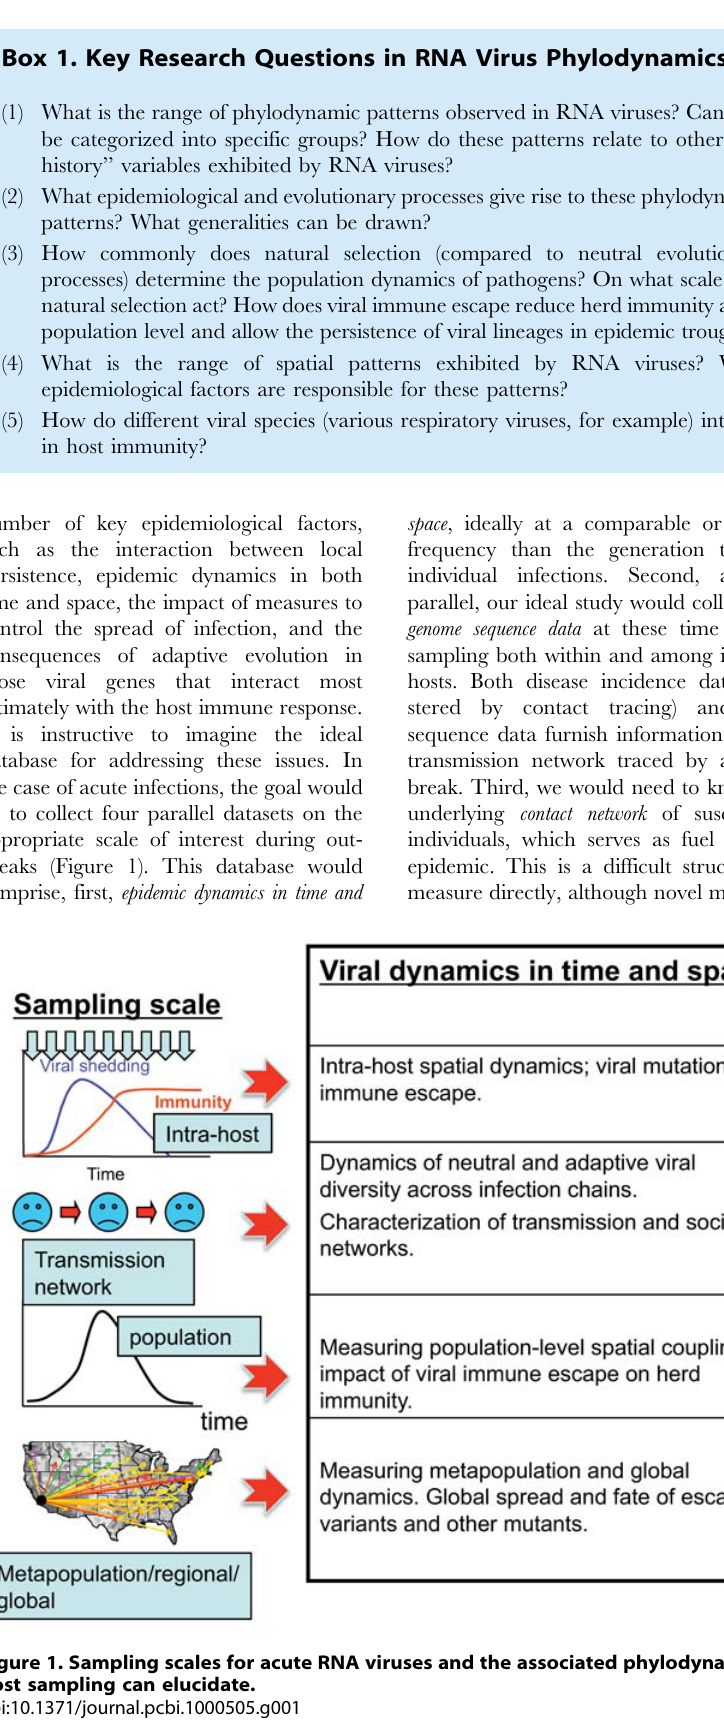
Box 1. Key Research Questions in RNA Virus Phylodynamics